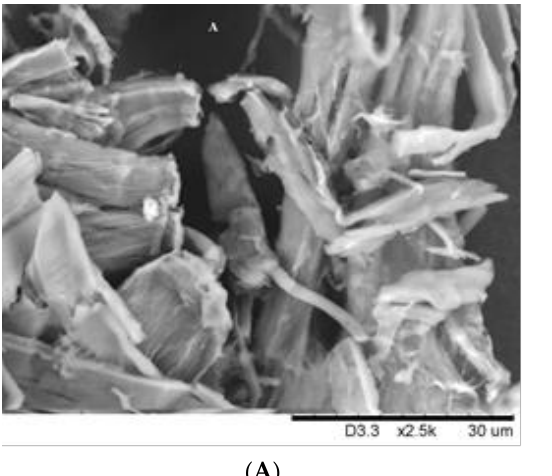
( b ) Figure 9. Hydrodynamic particle diameter ( a ) and ζ -potential of suspended particles ( b ) of nano- cellulose samples 1 – MCC and 2 – MFC. The MFC particle size distribution is narrow and the average nanofiber size is 91.2 nm (curve 1 in Figure 9a), while for MCC a wide range (from 400 to 1200 nm) was ob- tained (curve 2 in Figure 9a). The MCC average particle size is 712.3 nm. The ζ -potential is an important parameter for studying the stability of dispersion of cellulose fibers in an aqueous suspension. In this work, the average ζ -potential was found to be -13.4 mV for the MCC aqueous suspension (curve 2 in Figure 9b) and − 23.3 mV for the MFC aqueous suspension (curve 1 in Figure 9b ). The negative ζ -potential value is explained by the presence of negatively charged sulfate groups on the nanoparticles surface and points out the high stability of the MFC suspensions, since the obtained value 051015 20253035 0